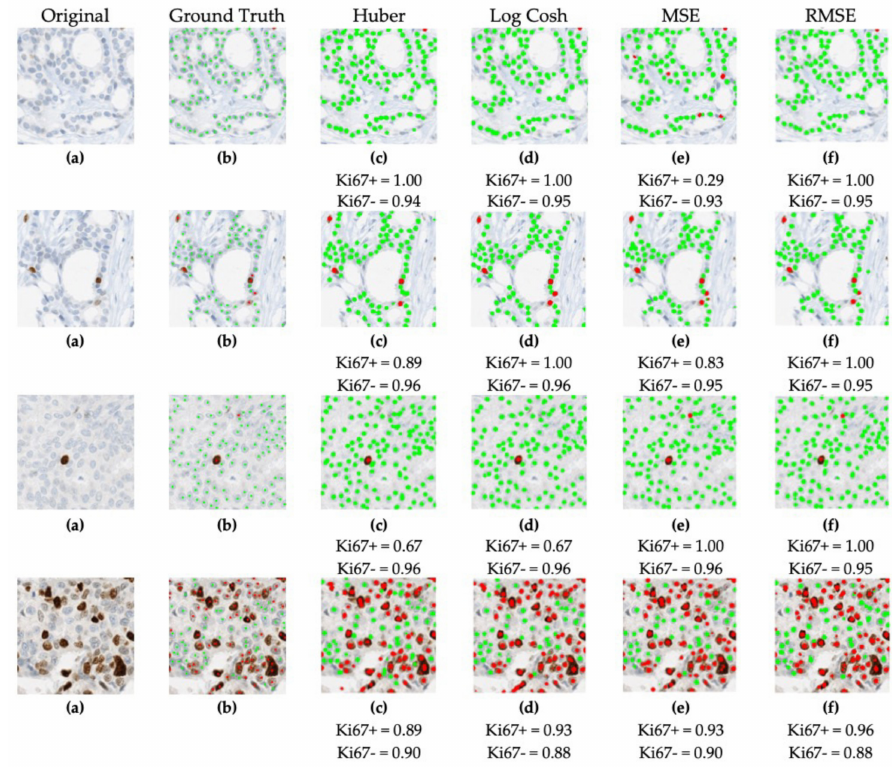
Figure 8. Visual representation of four patches of the ( a ) original image and corresponding ( b ) ground truth annotations alongside each loss function trained model’s output, ( c ) Huber, ( d ) Log − Cosh, ( e ) MSE, ( f ) RMSE.